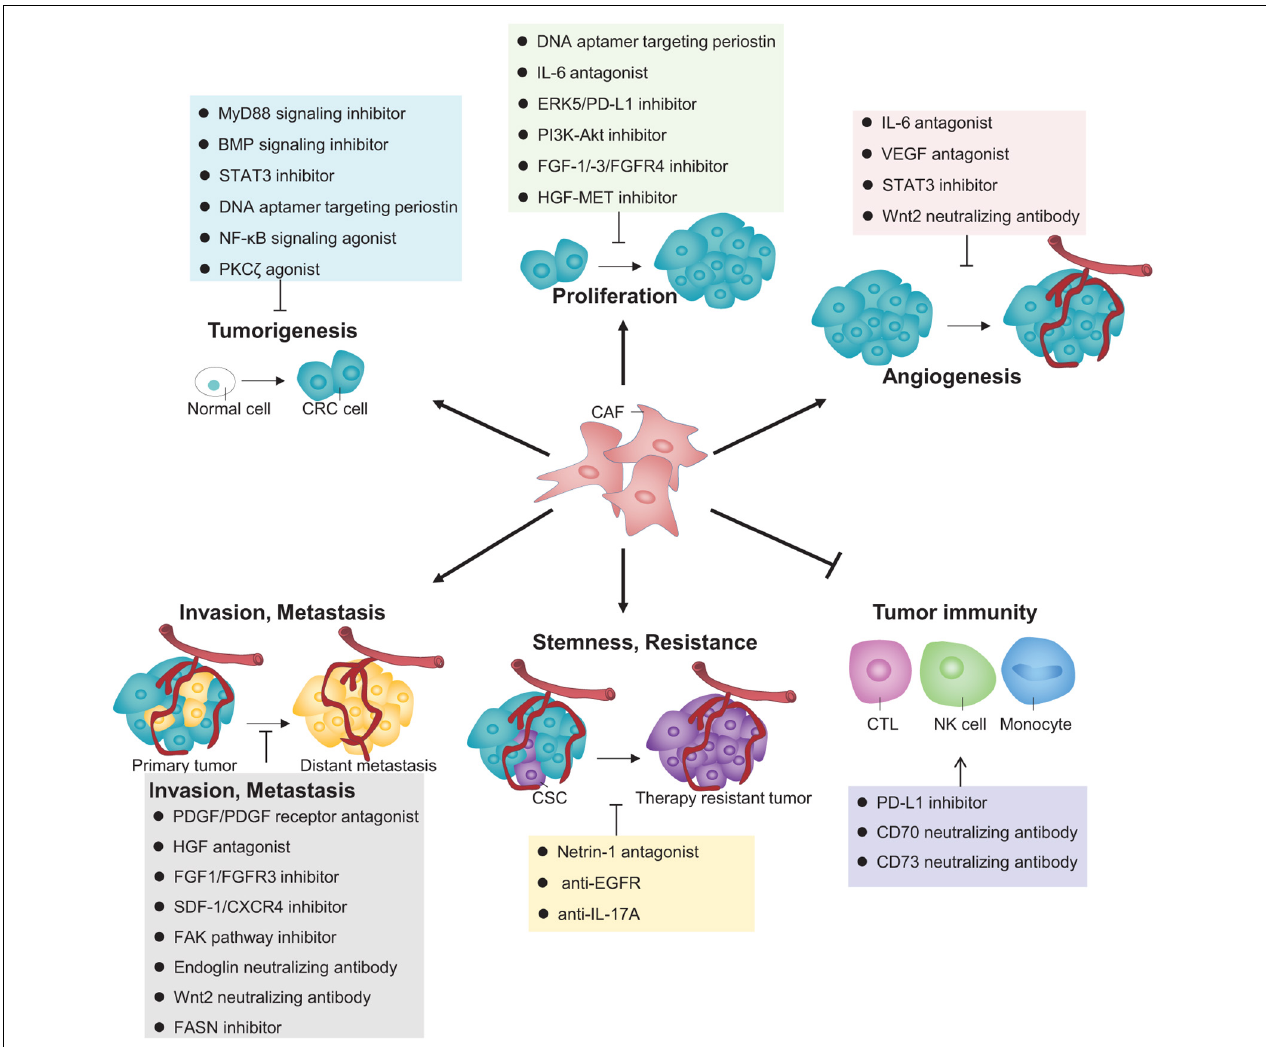
FIGURE 2 | Therapeutic strategies that target CAFs for CRC treatment. A variety of inhibitors, agonists, or neutralizing antibodies targeting different signaling pathways or molecules that contribute to CAFs’ versatile roles are proposed to interfere some key processes during CRC pathogenesis for clinical